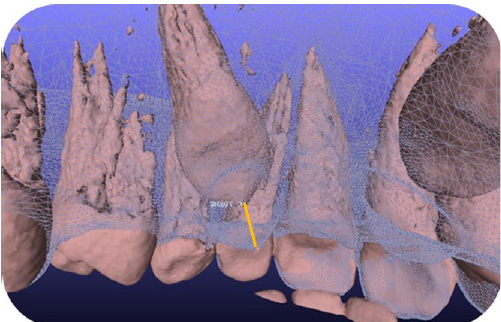
Figure 8. Measurement of the eruption values (distances between the cusp of the canine at T0 and the cusp of the canine erupted on the palate at T1 and T2) in mm.